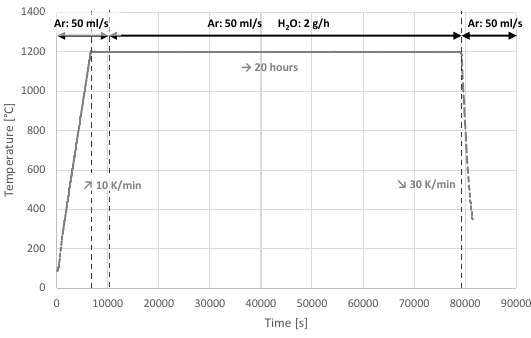
Figure 2. Isothermal